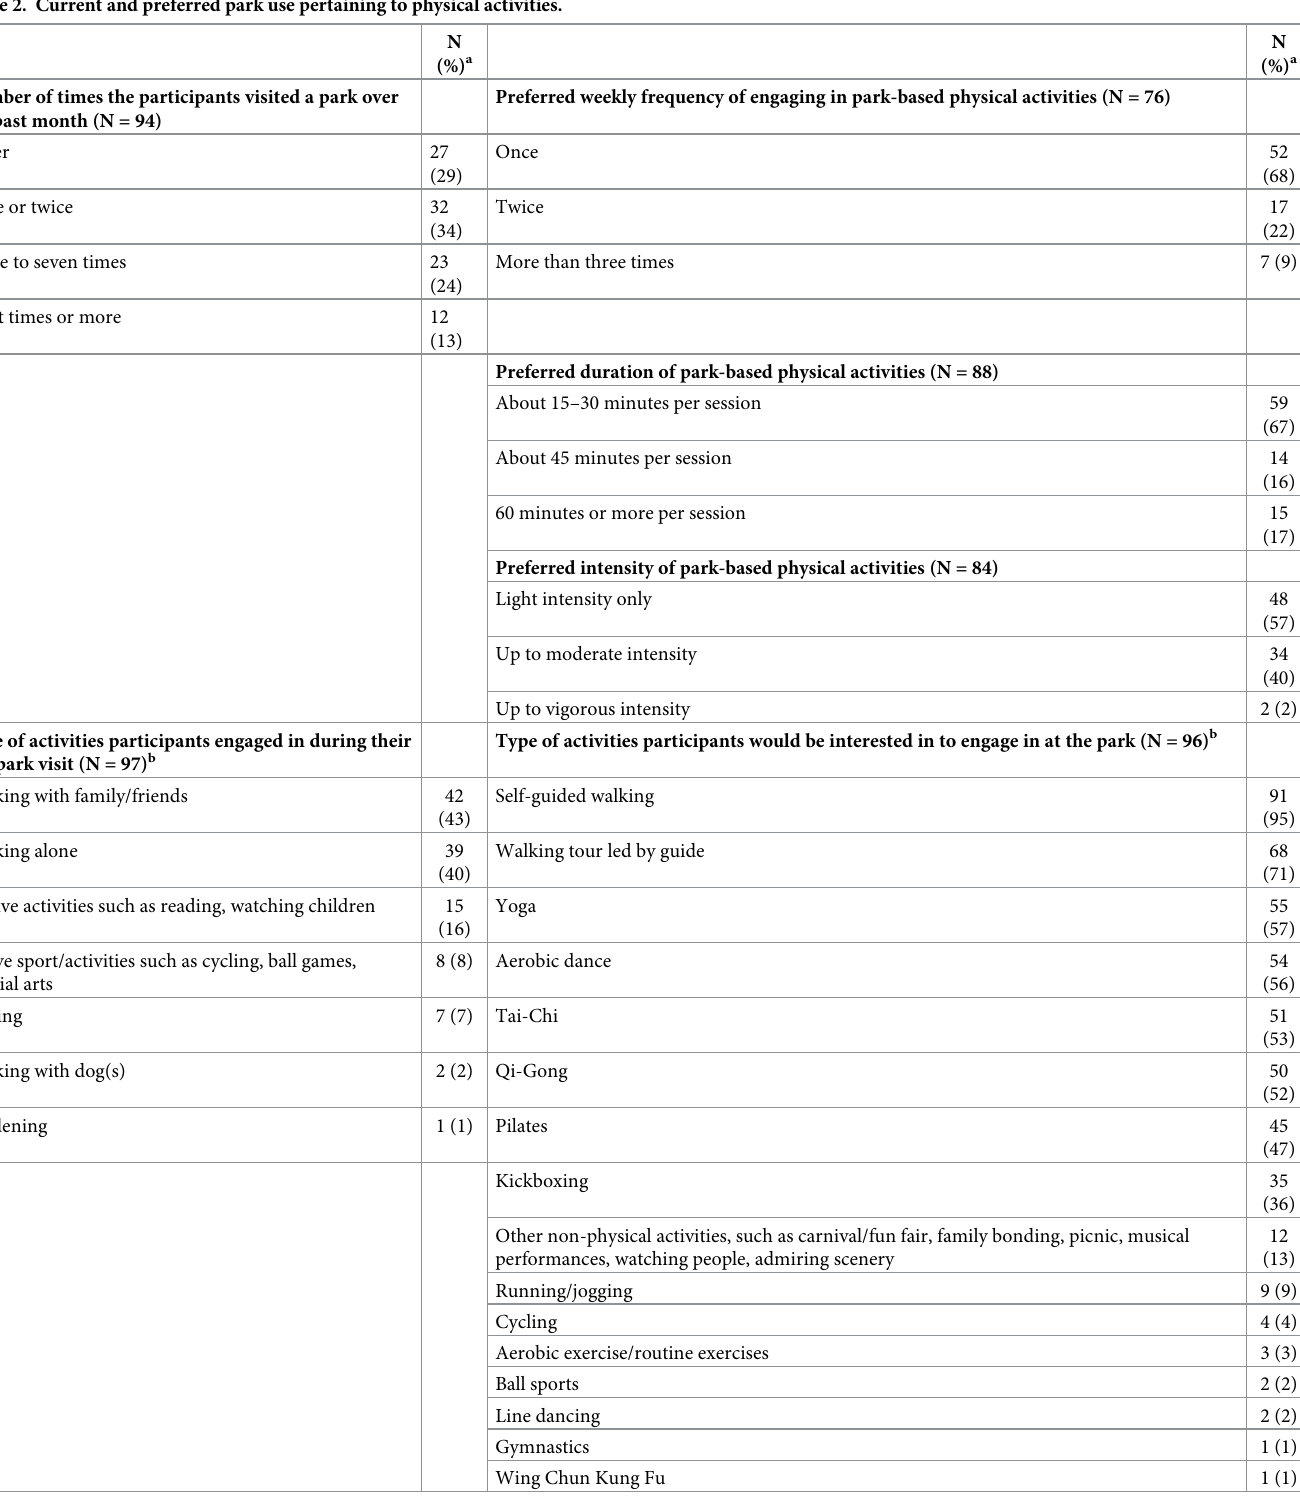
Table 2. Current and preferred park use pertaining to physical